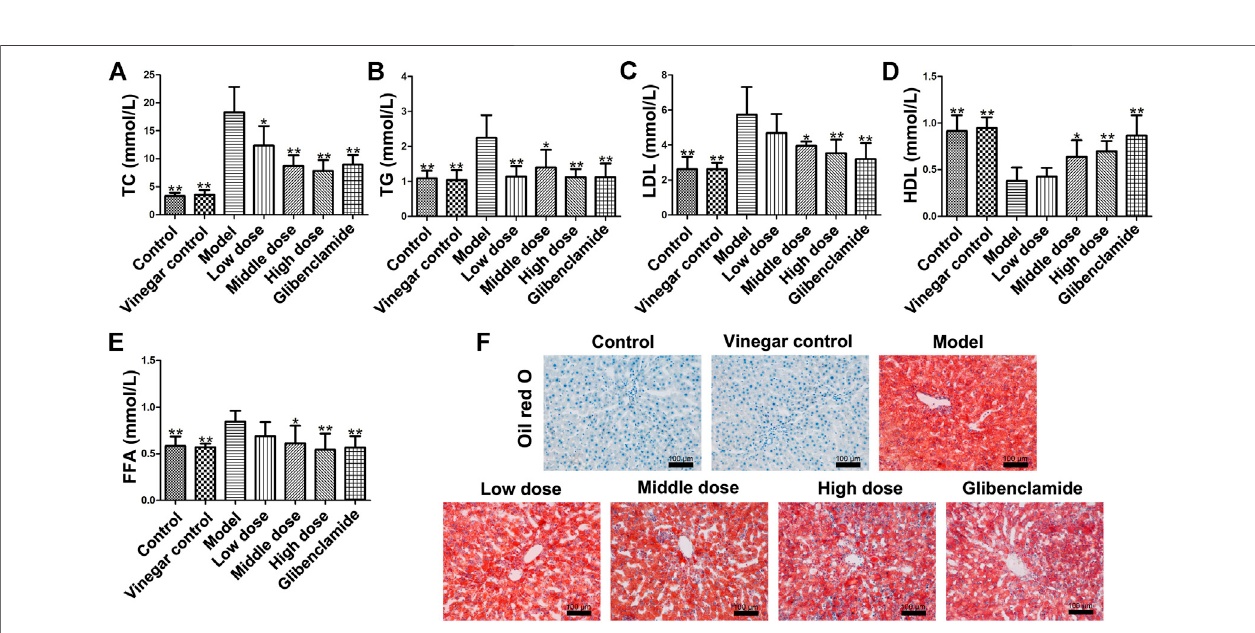
FIGURE 4 | Effect of HSAV on lipid metabolism of T2DM rats. (A) TC; (B) TG; (C) LDL-C; (D) HDL-C; (E) FFA; (F) Oil Red O staining of liver tissue. Data are presented as the mean ± SD (n (cid:2) 10). * p < 0.05 and ** p < 0.01 compared with model group.